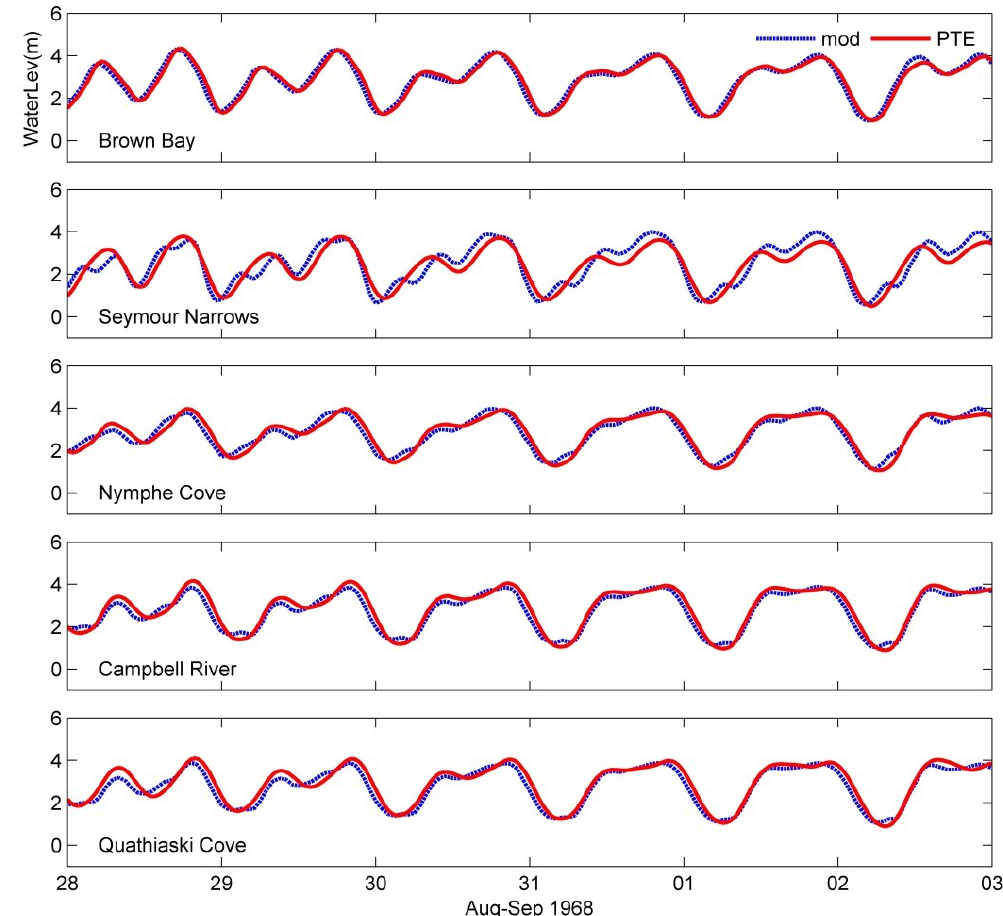
Figure 6. Model generated water levels (mod, dashed lines) at the 5 long-term tidal elevation sites as marked in Figure 1, with comparisons to the predicted tidal elevations (PTE, solid lines) derived from CHS tidal data sets.